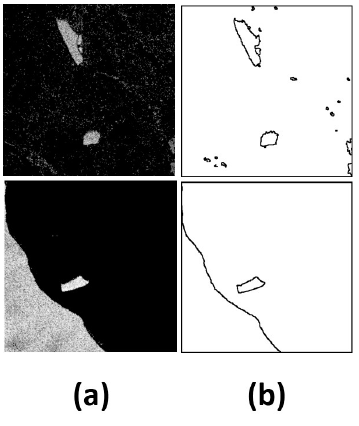
Figure 8. (a) SAR images of the areas referred to the Sector II in the map of Figure 6. (b) Edge detection result of applying the Adaptive Canny method.